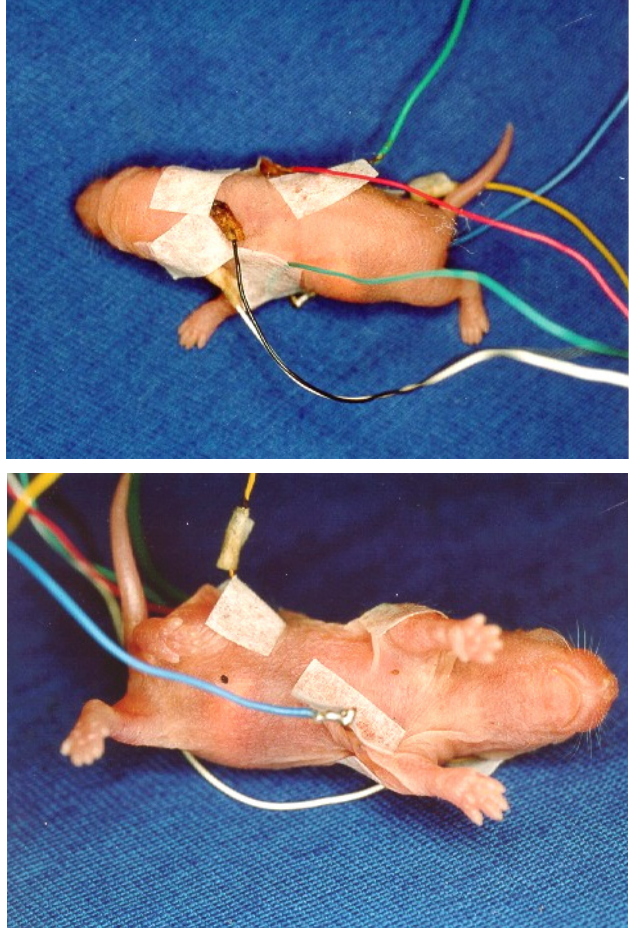
FIGURE 1 - Long steel fish-hooks used as electrodes positioned for EMG and EKG recordings in neonatal